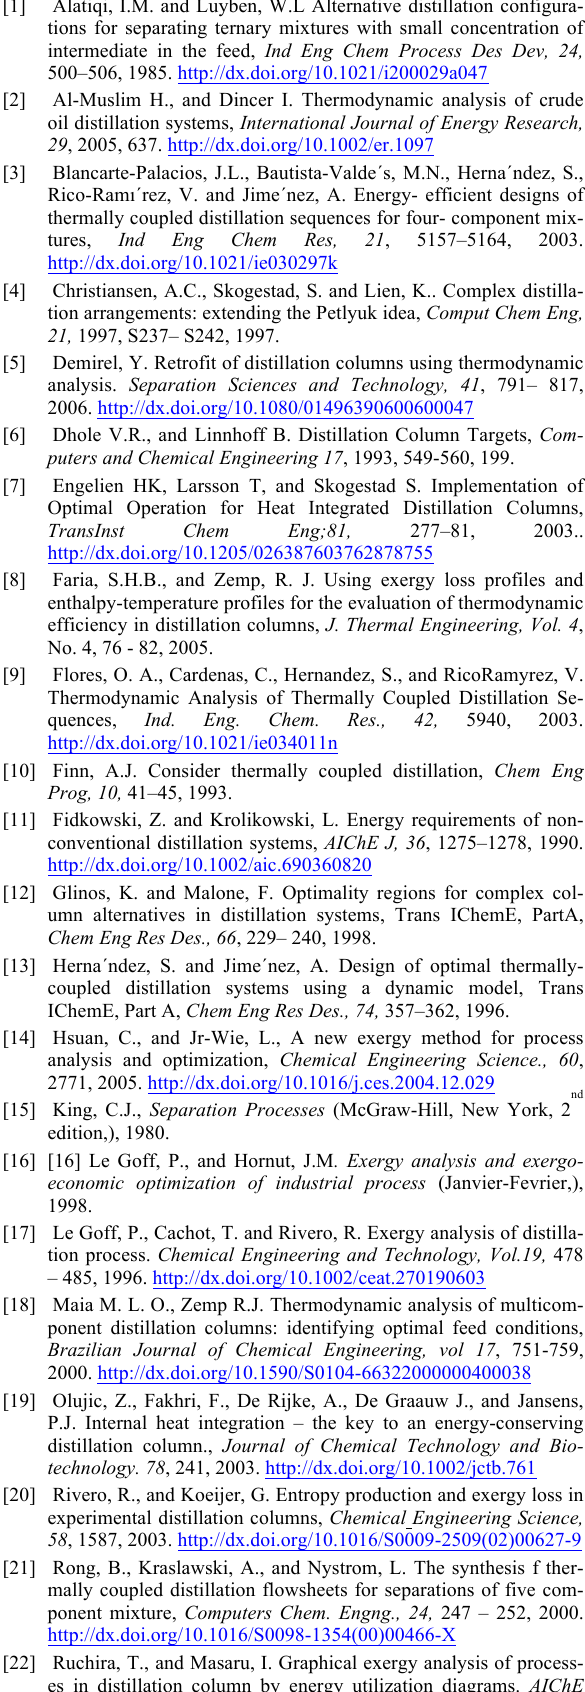
TABLE I. COLUMNS AND SYSTEMS EXERGETIC EFFICIENCY FOR